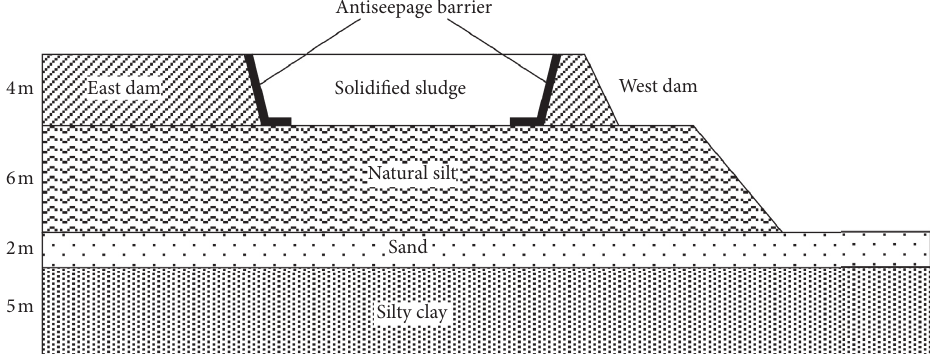
Figure 2: Schematic of Fuyong sludge